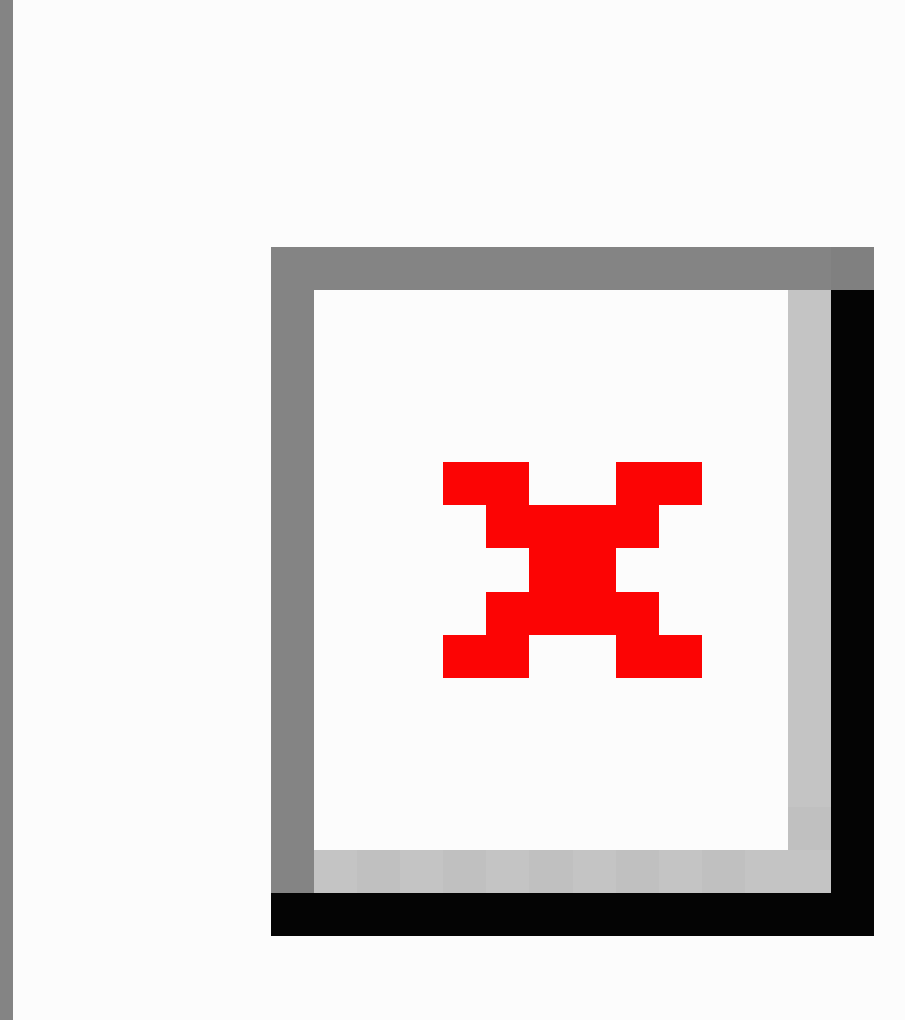
Figure 1. Study procedure for each